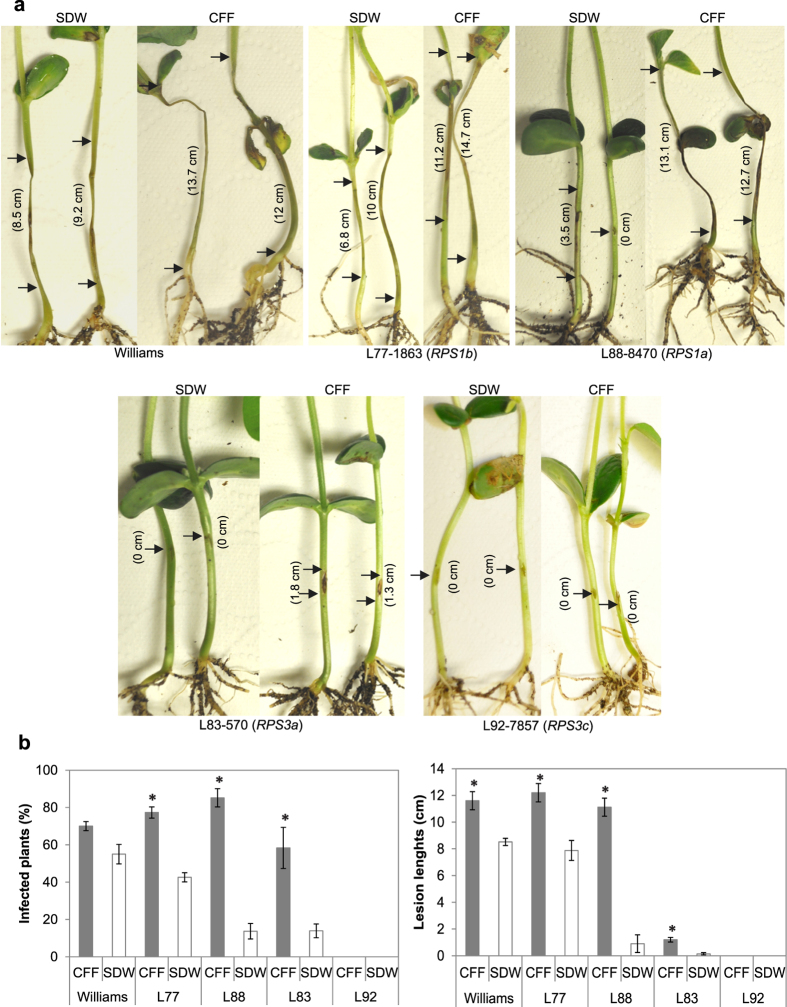
Sb5 cell-free filtrate (CFF) affects the responses of soybean differentials to Phytophthora sojae race 25.(a) Hypersensitive response of hypocotyls 4 days after being injected with the pathogen mycelia suspended in CFF or sterile distilled water (SDW). Length of lesion at the inoculated site is marked between arrows. CFF treatment resulted in expanded lesions on two susceptible varieties (Williams and L77-1863) and one resistant variety (L88-8470) and necrotic lesions on the resistant variety L83-570 but not L92-7857. (b) Infection rate and lesion size are means of three repeating experiments. Bars in columns depict standard errors. *depicts significant difference between the CFF treatment and the SDW control according to t-test assuming unequal variances (P = 0.05).